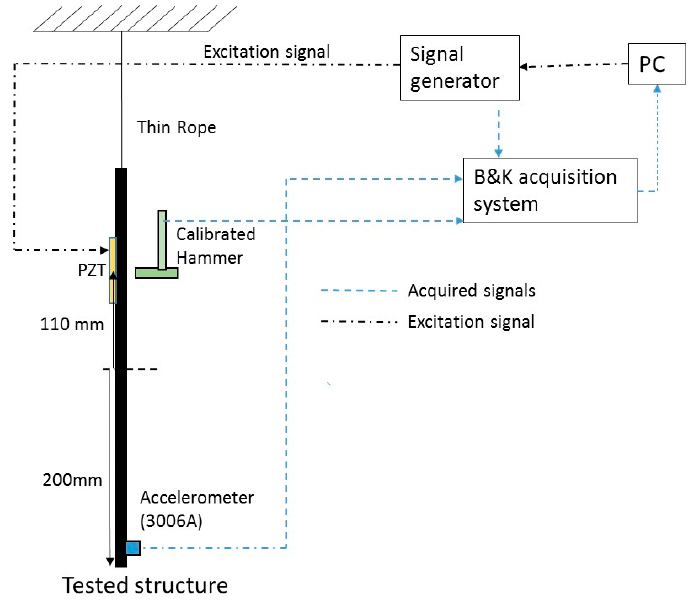
Figure 2. Equipment used.